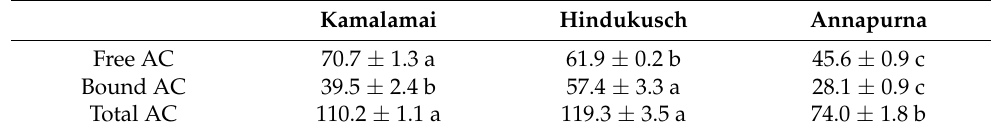
Table 7. Antioxidant Capacity ( µ mol Trolox/g) of whole barley